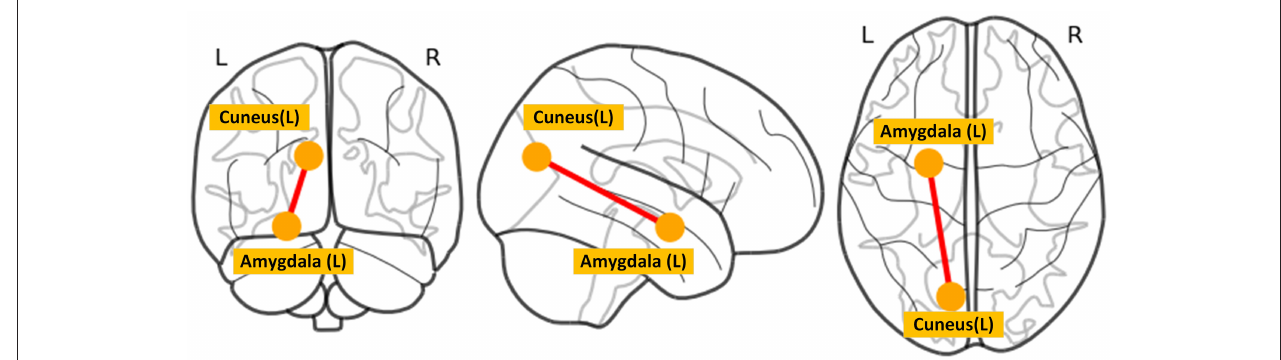
FIGURE 4 | The between-group difference of dFC strength in state 2. L, left; R, right.